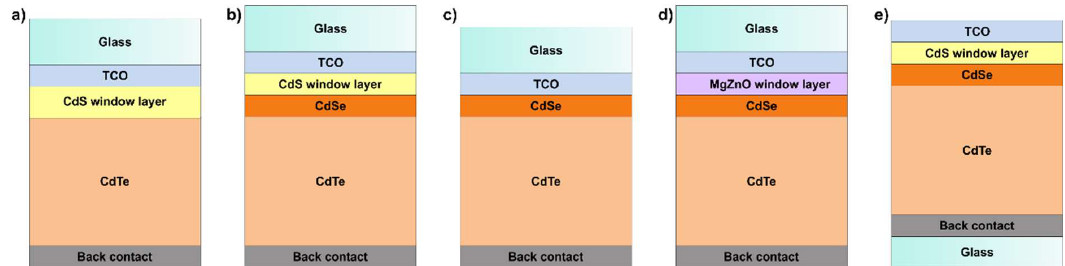
Figure 2. Schematics of deposited layers for solar cells (intermixing not depicted, thicknesses not to scale) for ( a ) a conventional CdTe device, ( b ) a device with a CdSe layer between CdTe and CdS [20]; ( c ) a device with CdSe replacing CdS [14,16]; ( d ) a device with MgZnO and CdSe replacing CdS [15]; and ( e ) a device in substrate configuration with a CdSe layer between CdTe and CdS [8]. Table 2. J - V parameters of the best CdTe 1− x Se x -containing devices for each configuration shown in Figure 2. Source